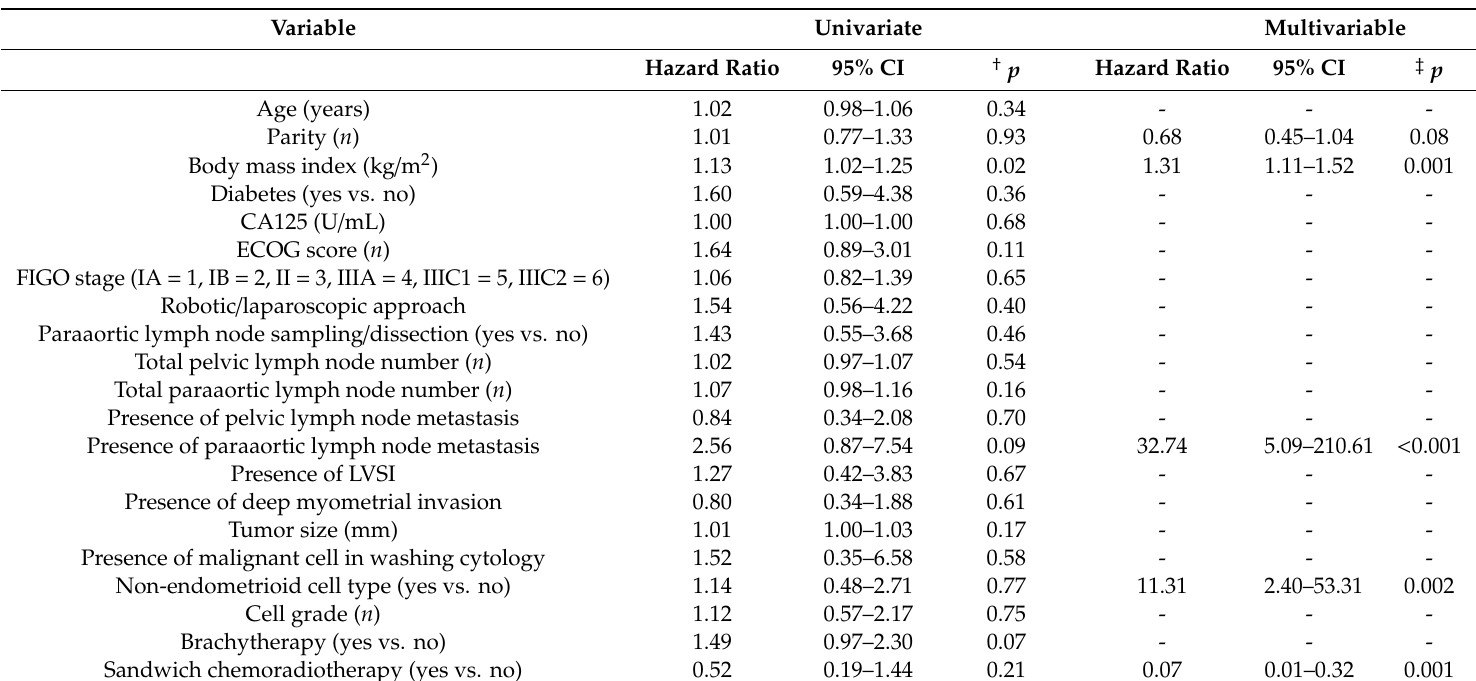
Table 4. Univariate and multivariable Cox proportional-hazards model for predicting overall survival after adjuvant therapy for women with high-risk endometrial cancer ( n = 92).